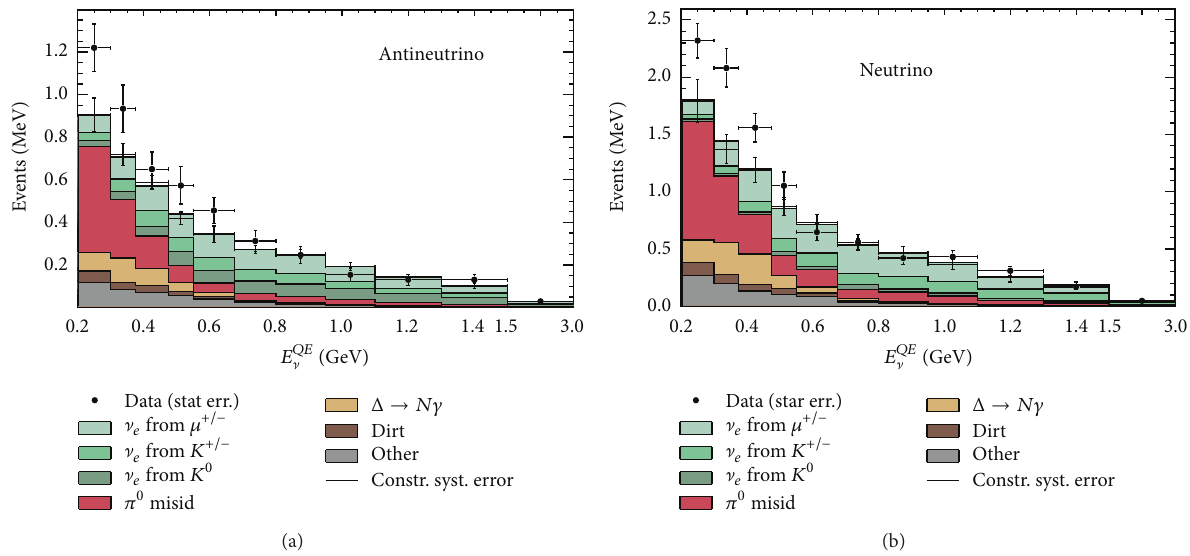
Figure 12: The MiniBooNE neutrino mode (a) and antineutrino mode (b) neutrino energy distributions for ] 𝑒 charged-current quasi-elastic data (points with statistical errors) and background (histogram with systematic